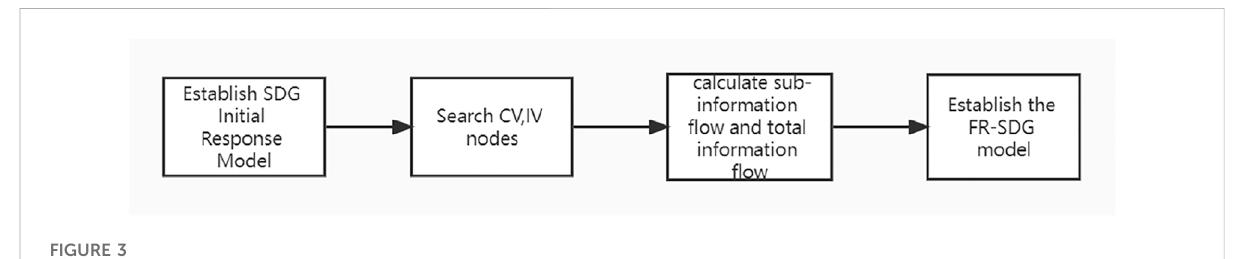
FIGURE 3 Flowchart of FR-SDG model